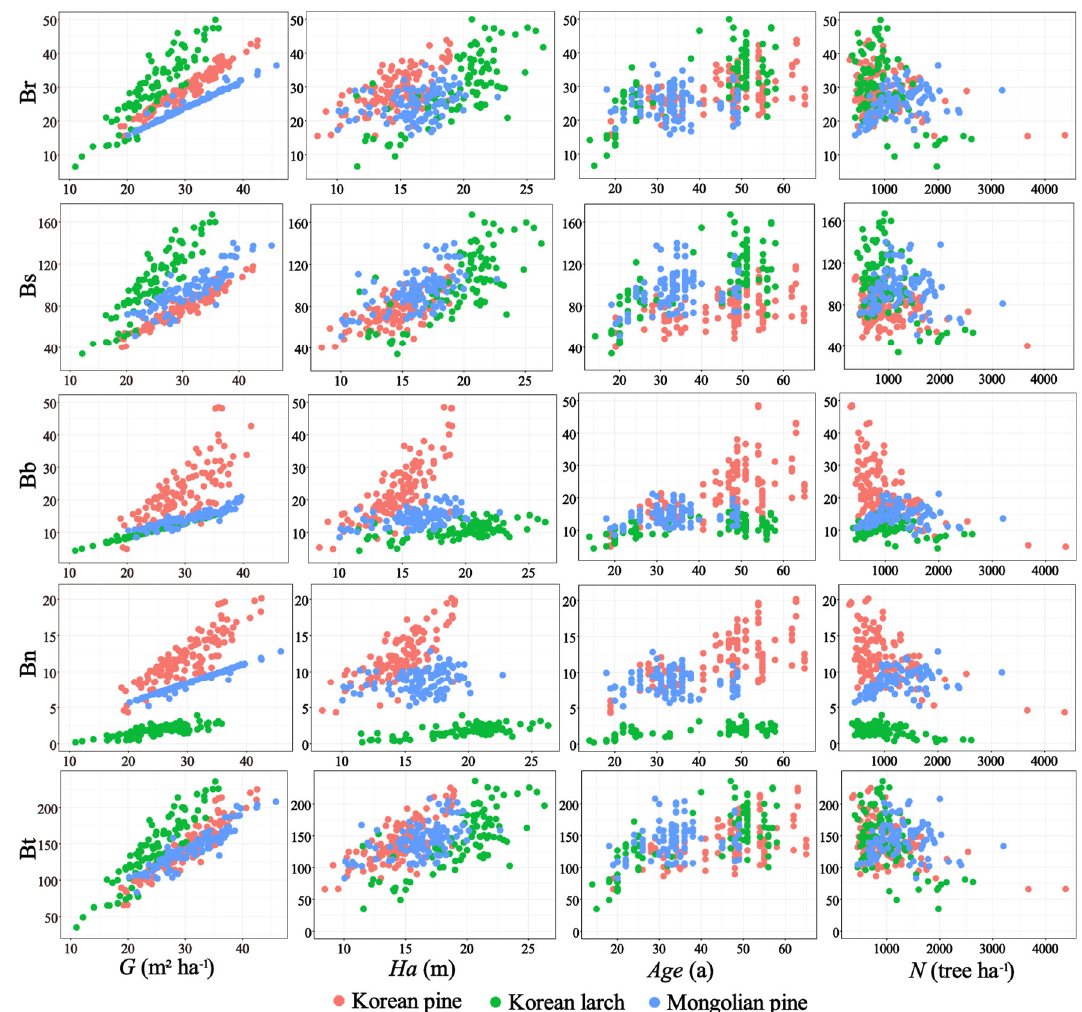
Figure 2. Scatter plot of total and component biomass (total (Bt), root (Br), stem (Bs), branch (Bb), and needle (Bn)) versus basal area ( G ), stand dominant height ( Ha ), stand age ( Age ), the number of trees per hectare ( N ).